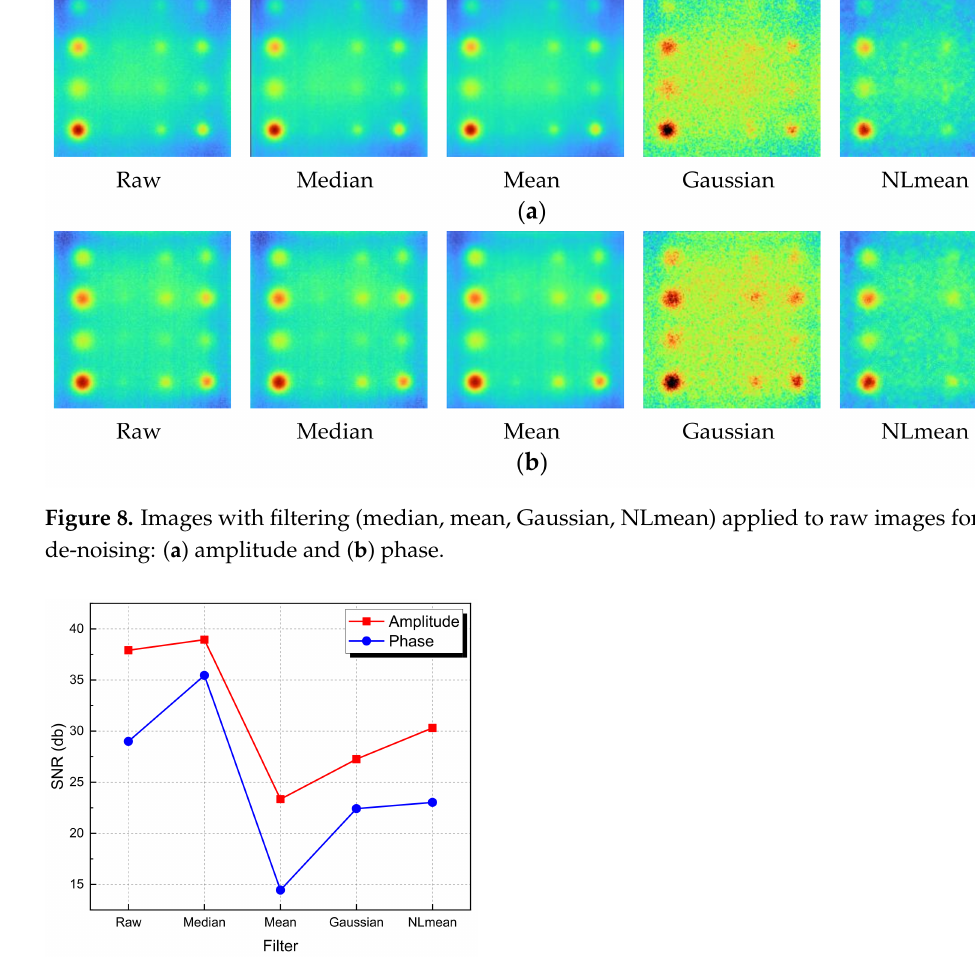
Figure 9. SNR comparison of each filtered image.